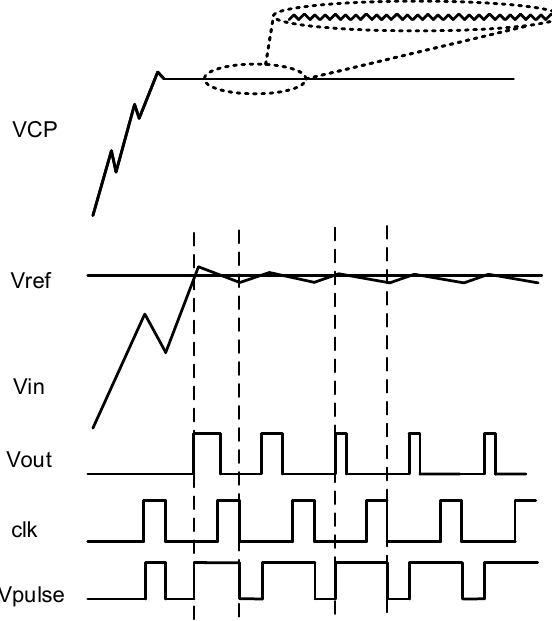
Figure 3. Control Signal Timing